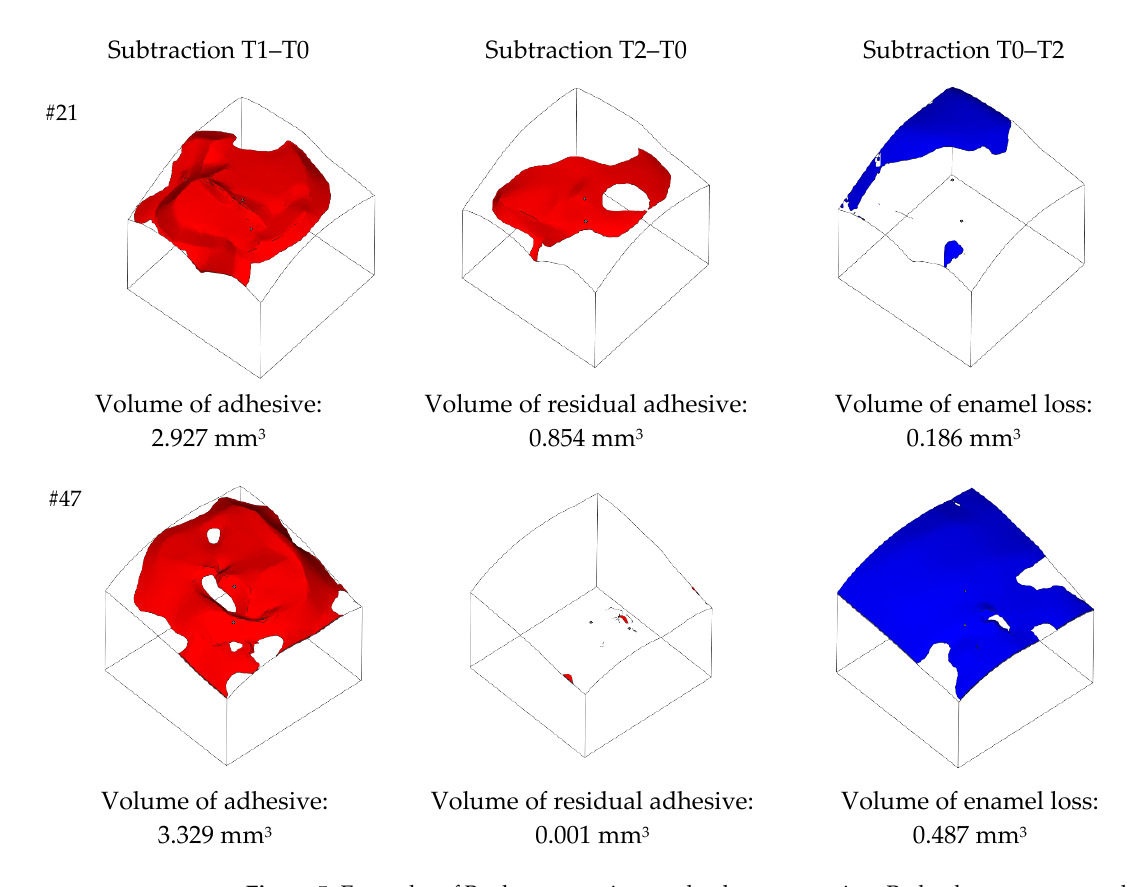
Figure 5. Examples of Boolean operations and volume extraction. Red volumes represent the residual adhesive, while blue volumes represent the enamel loss with respect to T0 condition.